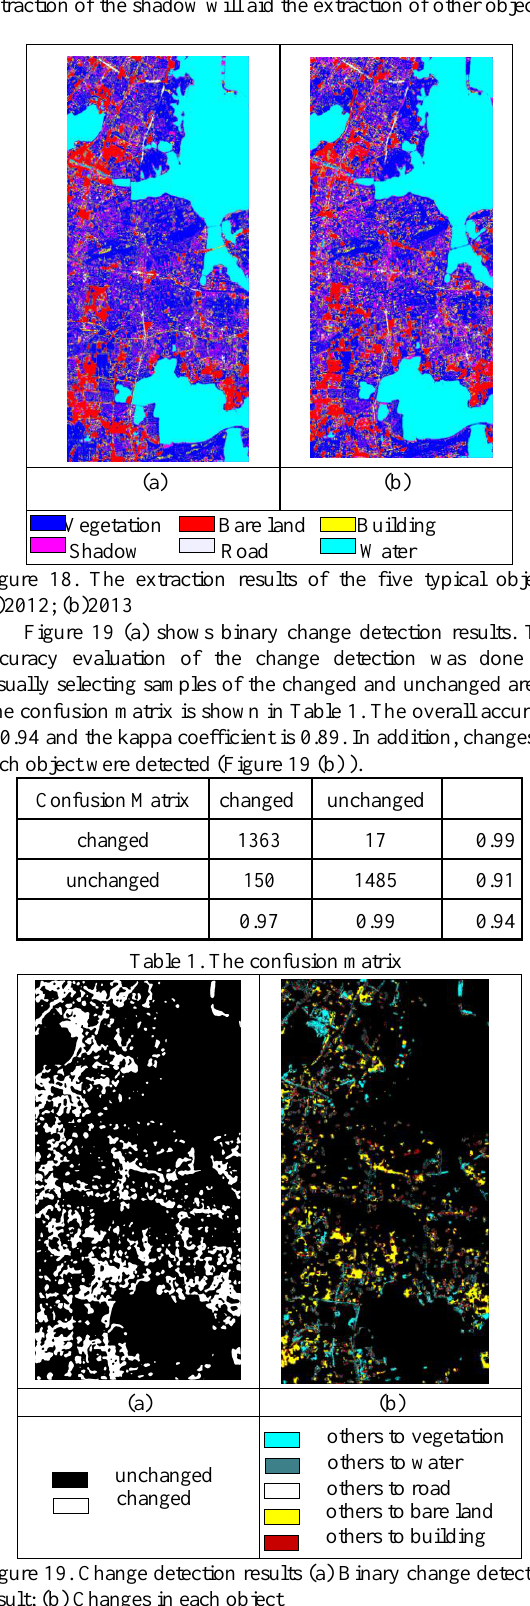
Figure 17. The bitemporal images (a) The image of 2012; (b)The image of 2013